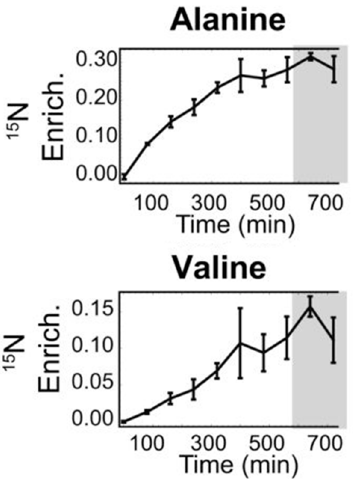
Figure 2. 15 N enrichment levels of two amino acids in barley leaves provided with 15 N-labelled KNO 3 , as determined by gas chromatography-mass spectrometry (GC-MS). Light periods are marked in white and dark periods in gray . Adapted with permission from [78].